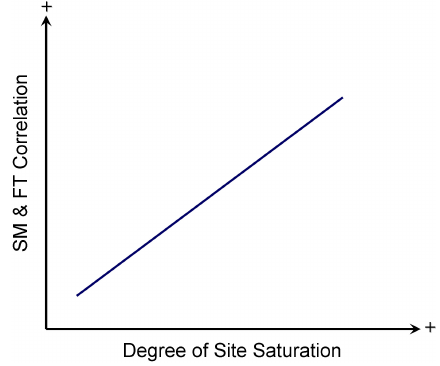
Fig. 11. Conceptual model illustrating the interaction of soil mois- ture (SM) and frost table (FT) over space as a function of site wet- ness. When the site soil moisture is relatively low (e.g. at the valley site), the interaction is more time dependent. When the site soil moisture is wetter (e.g. at the peatland and wetland sites), the inter- action becomes more